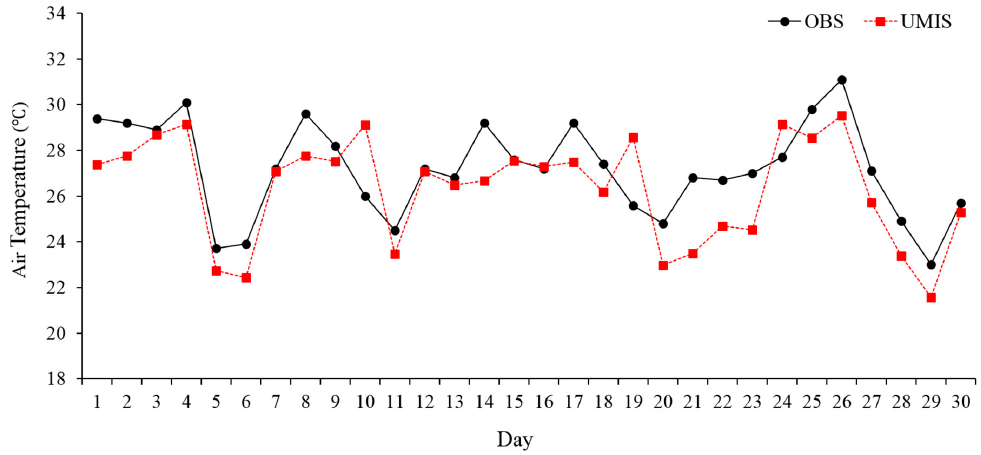
Figure 13. Accuracy evaluation for unforeseen events and seasonal fluctuations. Daily maximum temperature at the Seoul weather station (AWS #108): OBS, observed data; LDAPS, Local Data Assimilation and Prediction System; UMIS, Urban Meteorological Information System.